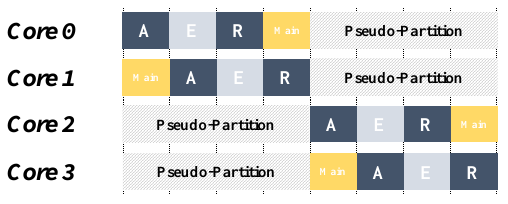
Figure 9. AER execution model with pseudo-partition.